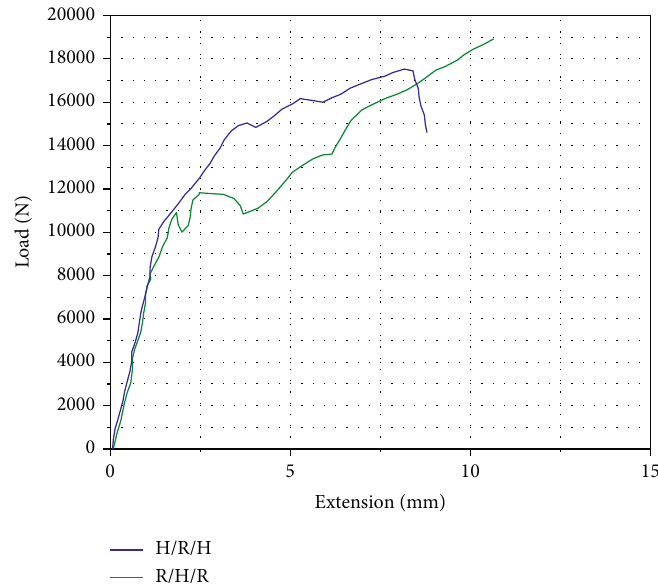
Figure 3: Load – extension curve for hybrid